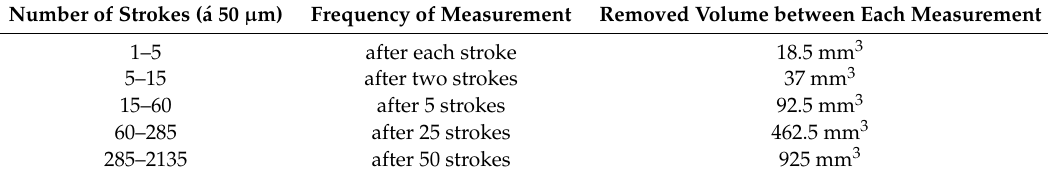
Table 1. Measuring intervals during the wear investigation.